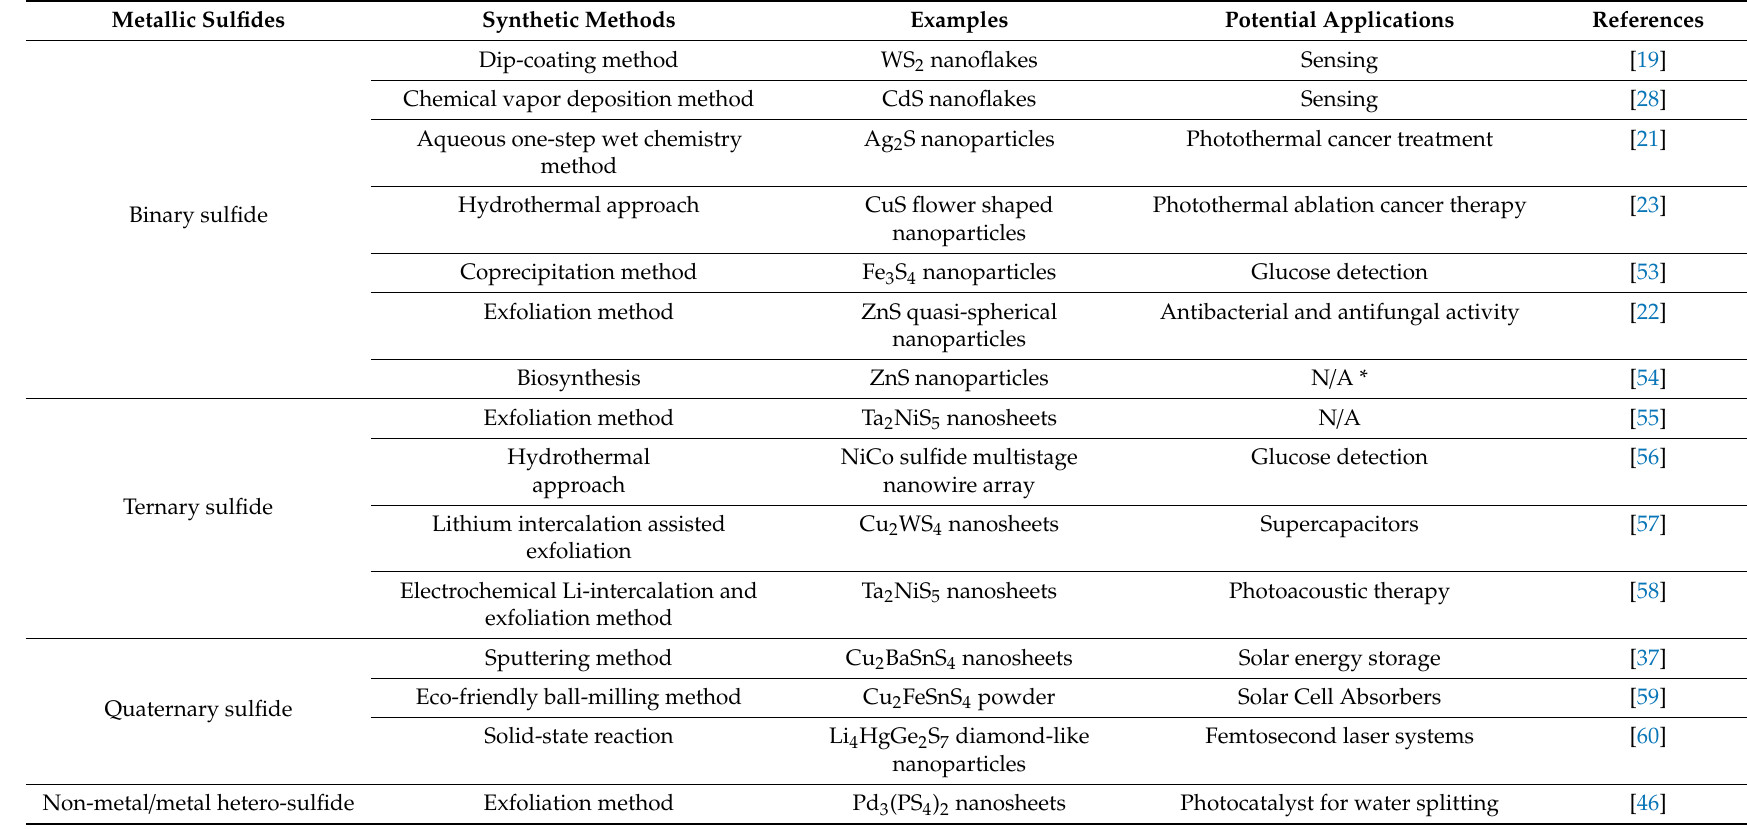
Table 1. Synthetic methods and potential applications of metallic sulfide